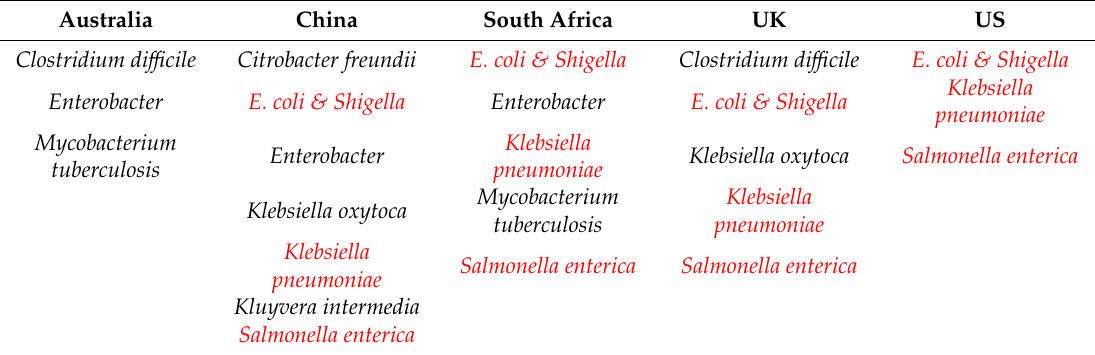
Table 3. The important pathogens identified from PCA and hierarchical clustering in five countries. Identified in red are the important pathogens found in all countries but